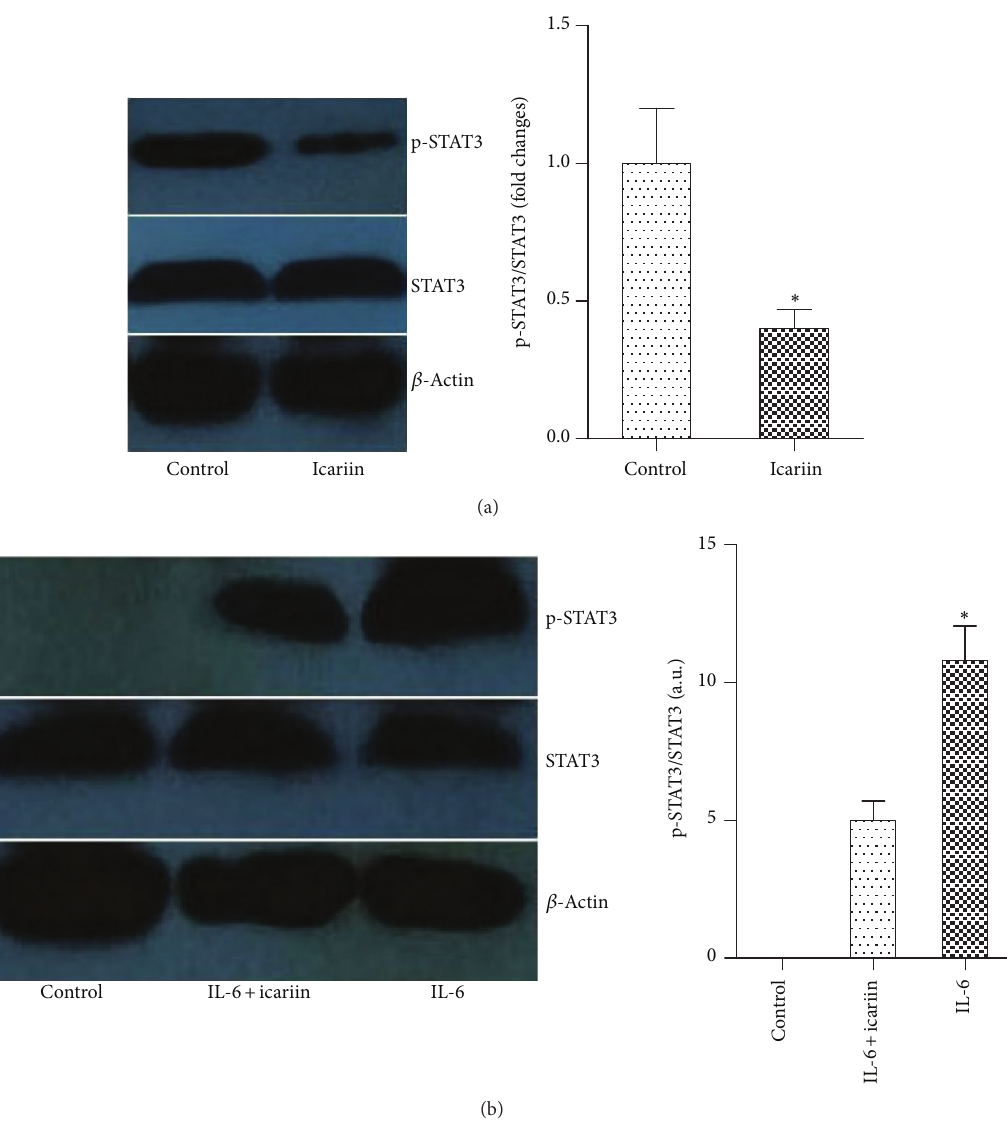
Figure 6: Icariin inhibited STAT3 activation in T cells in vivo and in vitro . (a) Synovial p-STAT3 protein level was analyzed using Western blotting. (b) Naive T cells from mice were treated with 3 𝜇 M icariin for 24 hours, followed by stimulation of IL-6 (25ng/mL) for 30 min. Protein levels were assessed using Western blot. ∗ 𝑃 < 0.05 versus all other groups, 𝑛 = 6